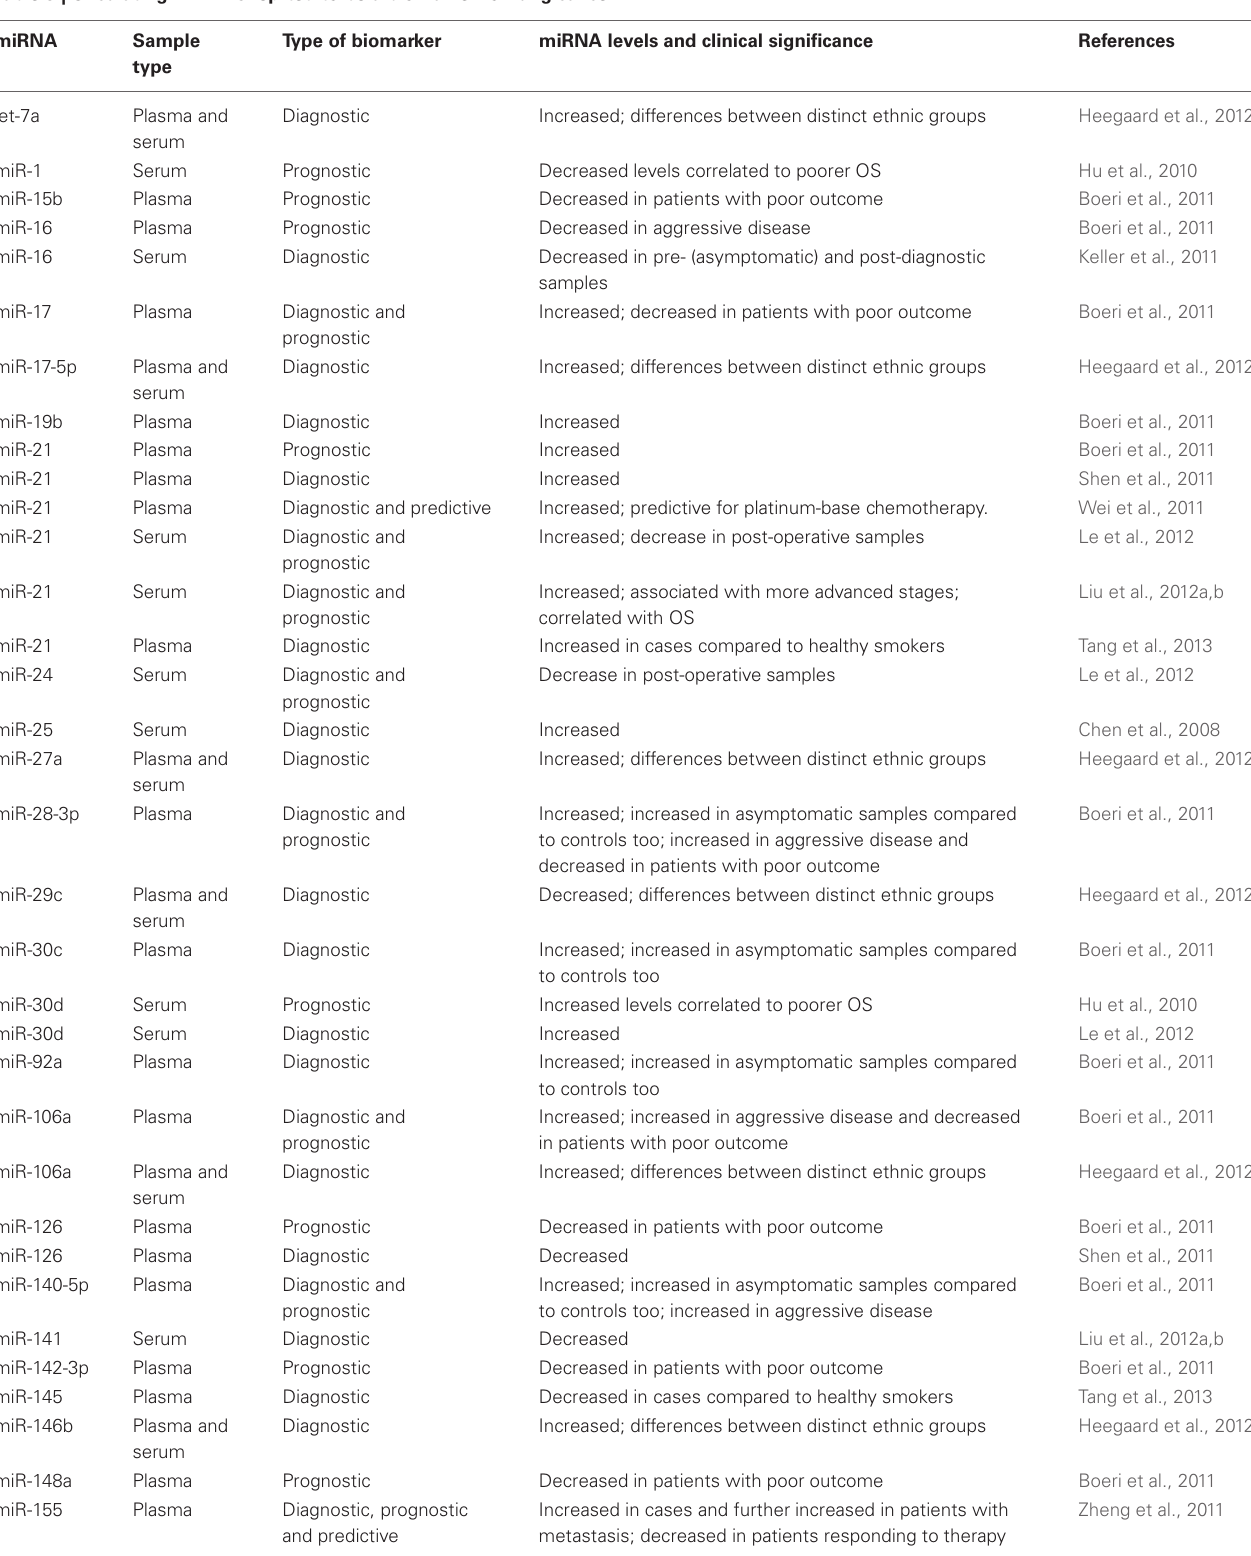
Table 3 | Circulating miRNAs reprted to be a biomarker for lung